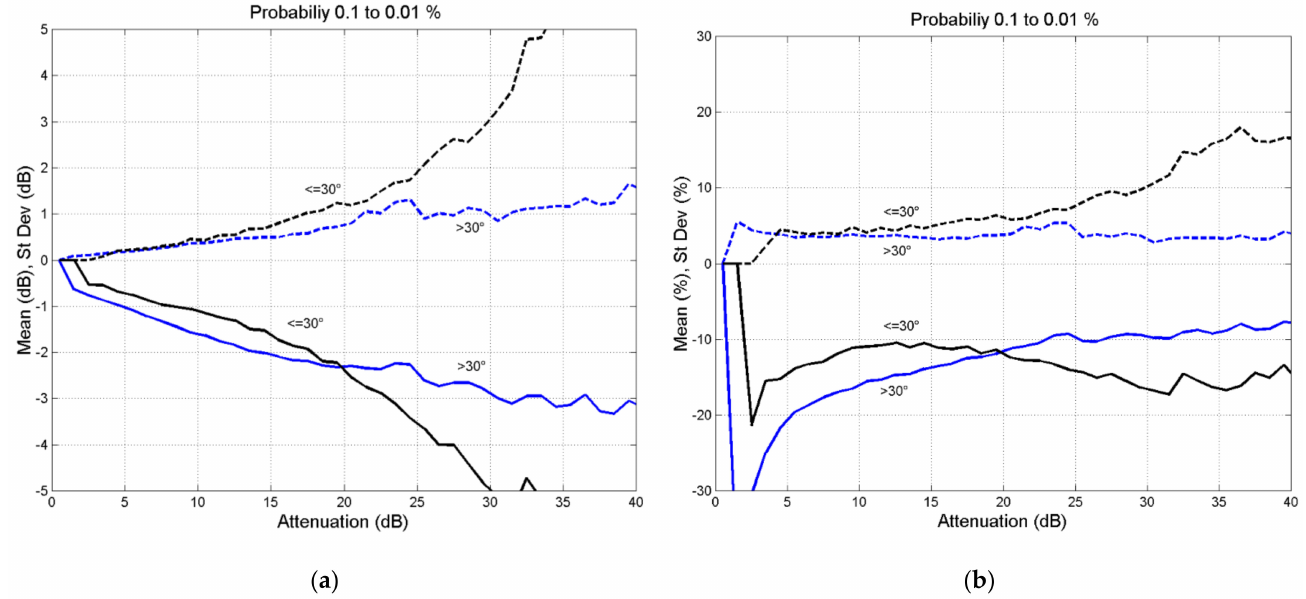
Figure 6. ( a ) Average (continuous lines) and standard deviation (dashed lines) of the error ε versus A SST ; ( b ) ε r . Probability range 0.1% to